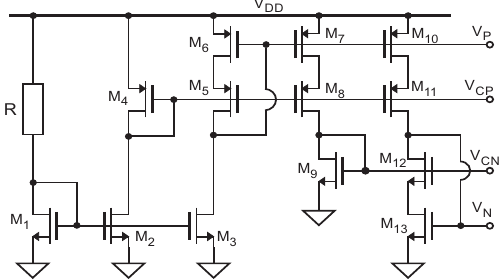
Figure 5. Implementation at transistor level of the bias